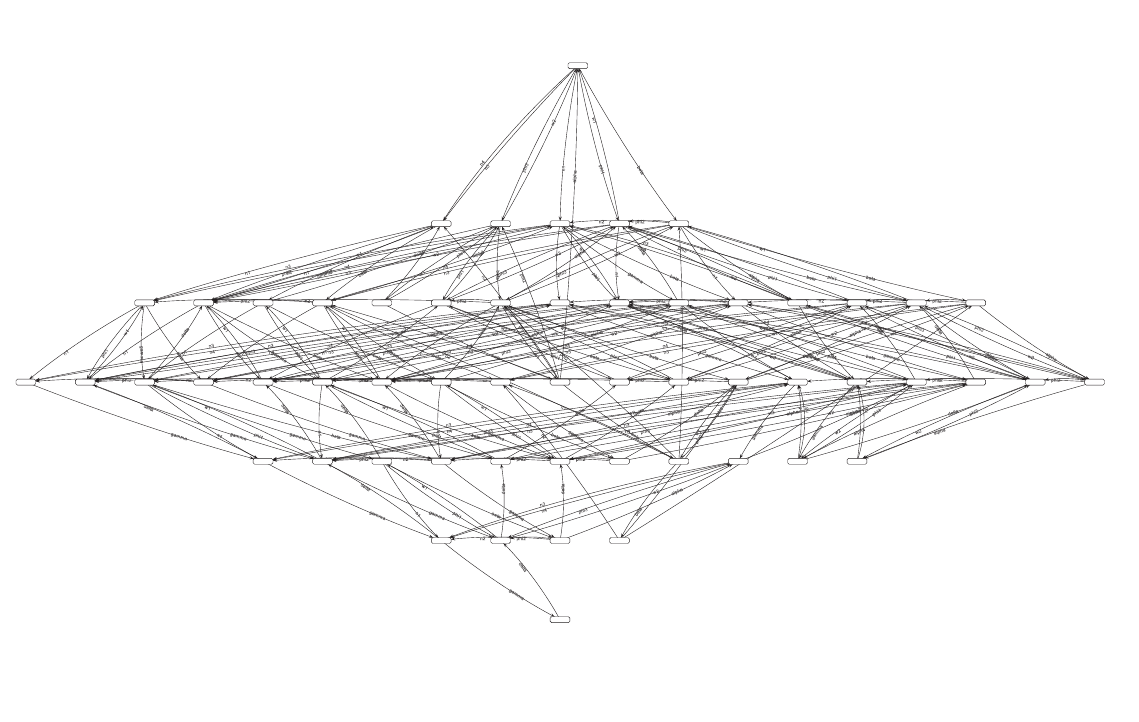
Fig 13. Reachability Graph. Fig 13 shows the reachability graph consisting of a total of 56 unique markings and 273 transitions with initial marking M 0 = (2, 0, 1, 0, 0,